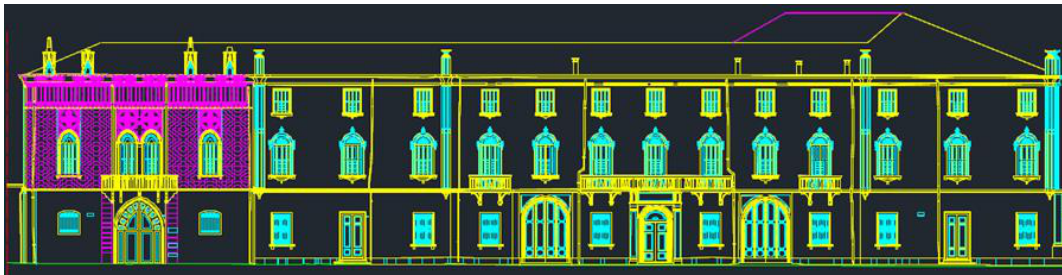
Figure 13: Elevation plan of the winter wing façade (south